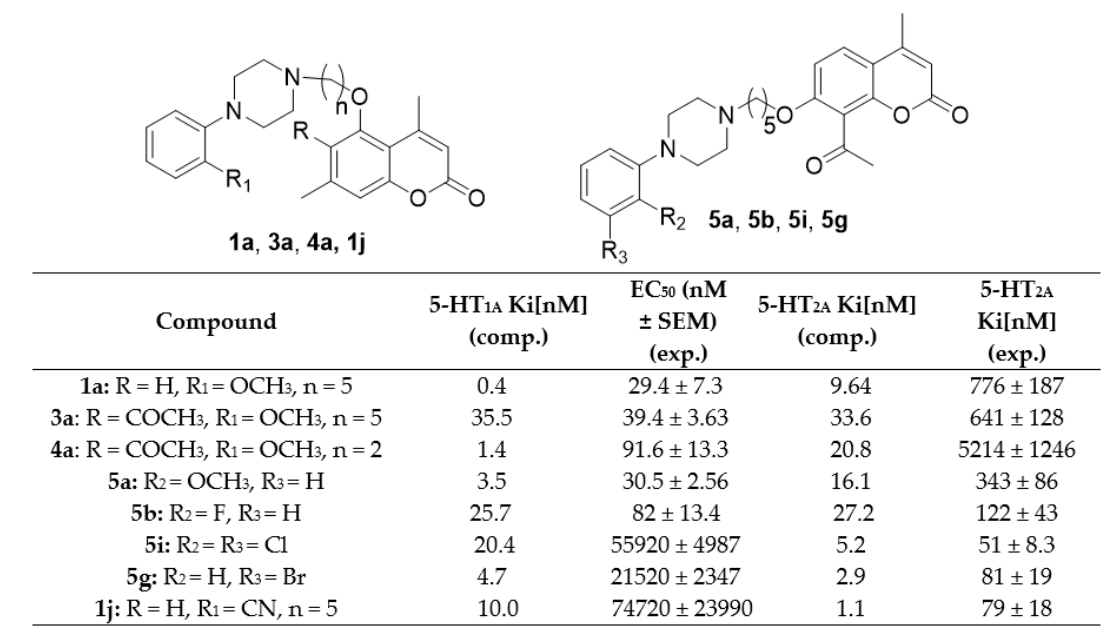
Figure 3. Summary of the results for the most active